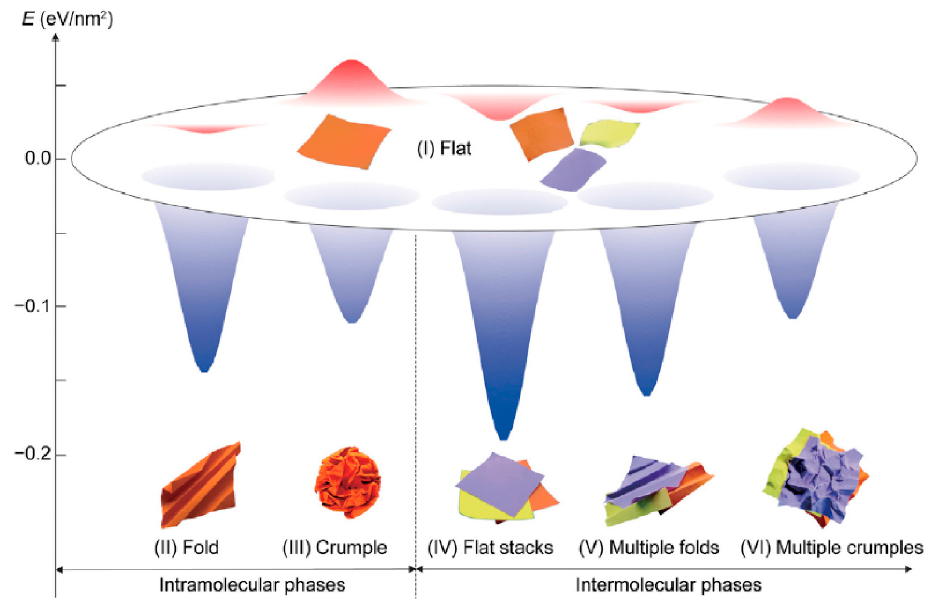
Figure 9. Conformation phase map of GO in solution accompanying the potential energy landscape. Reprinted with permission from [126].